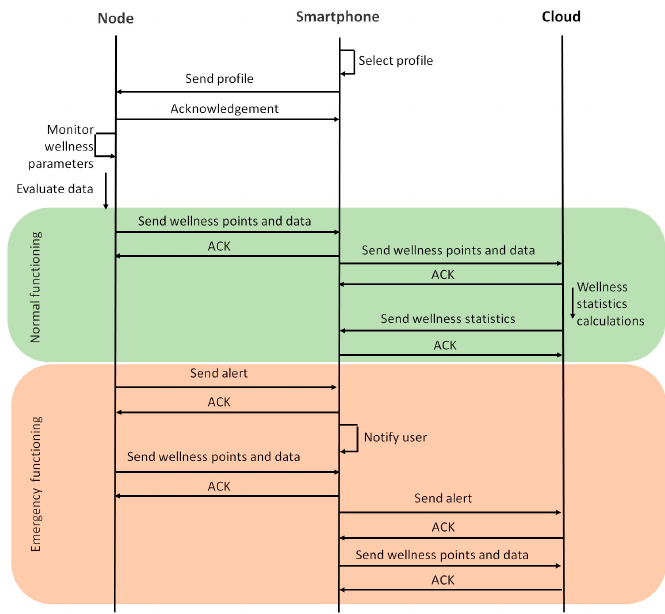
Figure 2. Message exchange between the elements of the system.